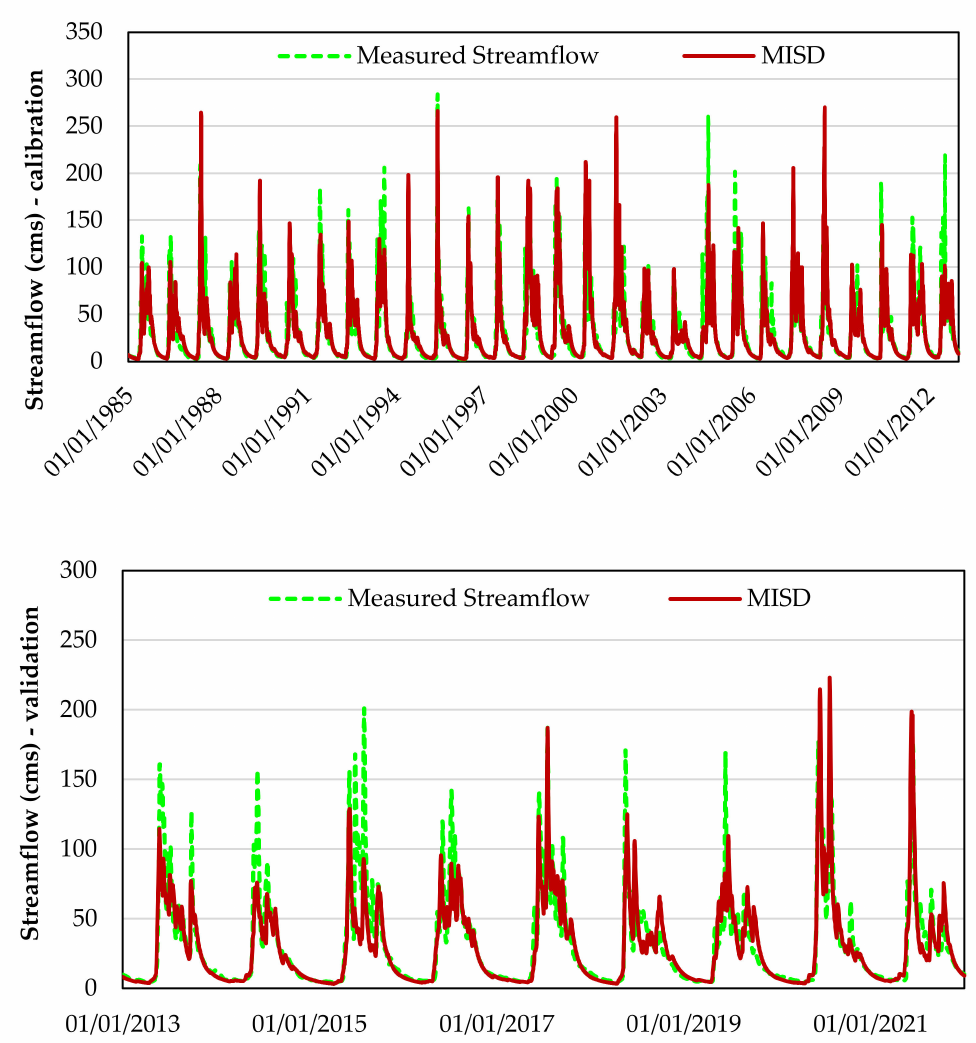
Figure 6. Hydrograph of observed vs. modeled streamflow by MISD